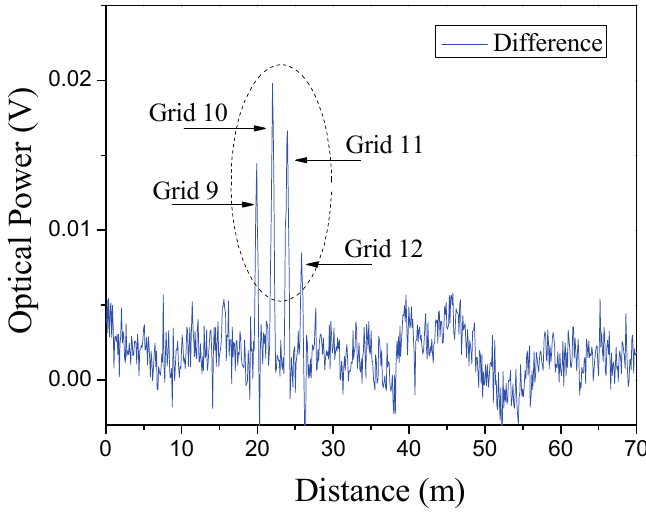
Figure 5. Difference of signal between pre and post ball drop (11.20